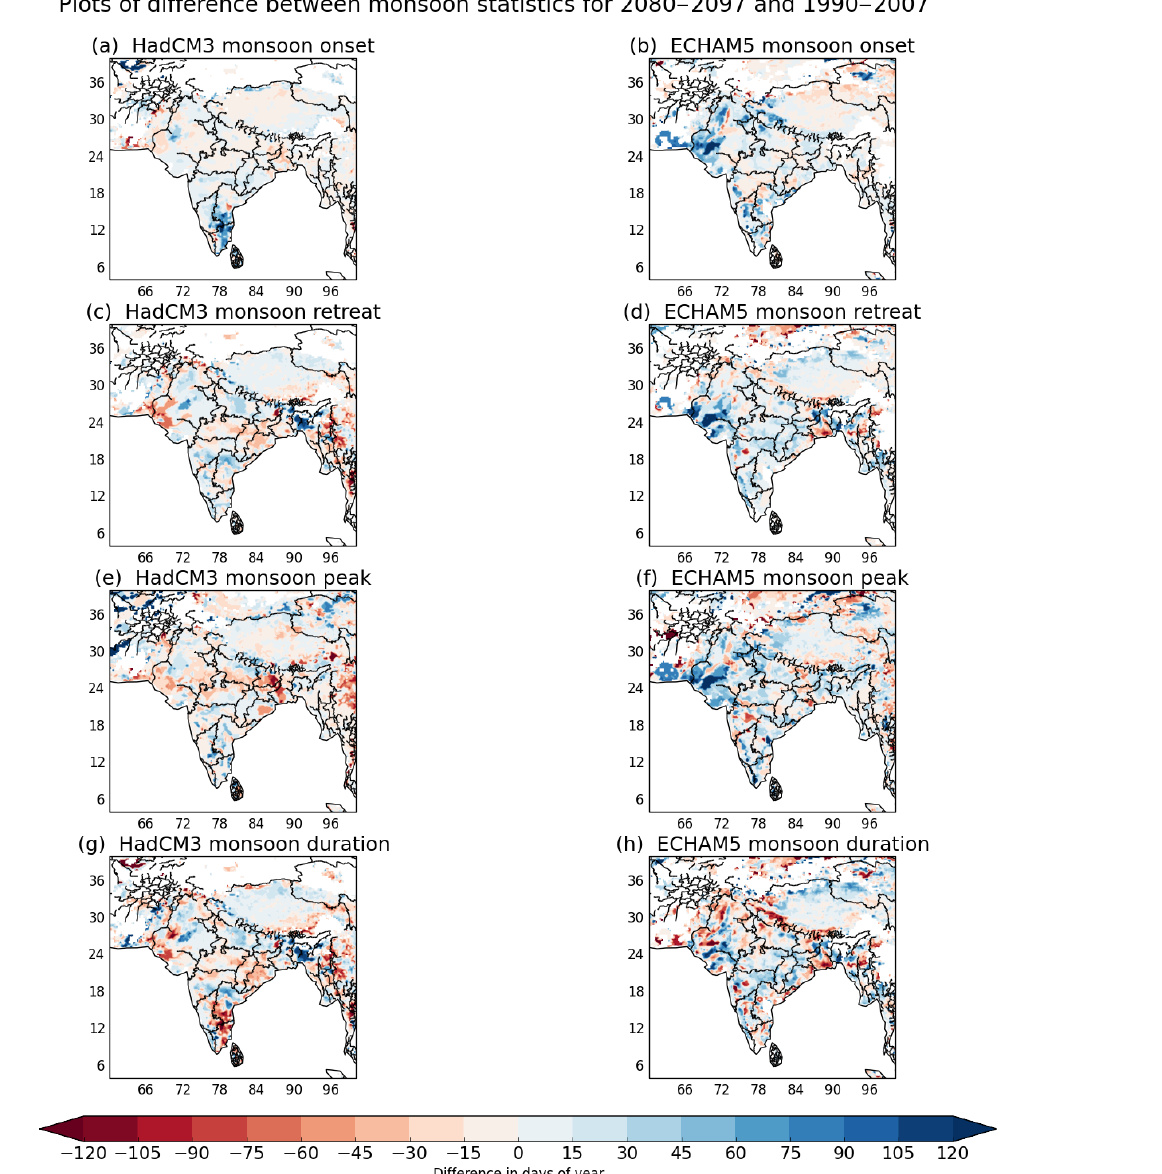
Figure D1. The difference between the monsoon statistics for the 2080–2097 future period compared with the present day 1990–2007 for HadCM3 (a, c, e, g) and ECHAM5 (b, d, f, h)